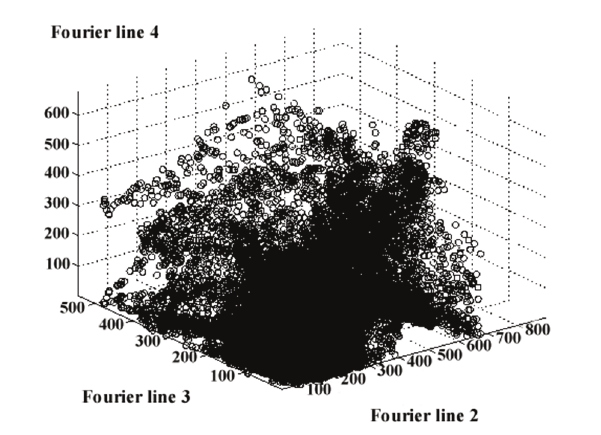
Fig. 3. An example view of a pattern created by points in a parameter space (find out that a dimension parameter space is 9 but at above figure there are only plot of three chosen parameters what can be visualized) Values of FFT line represent the number of sample in frequency domain which corresponds to the given